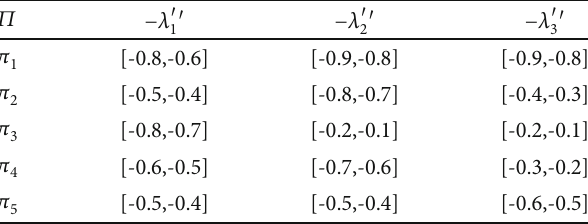
Table 17: The fi rst negative pole score table.